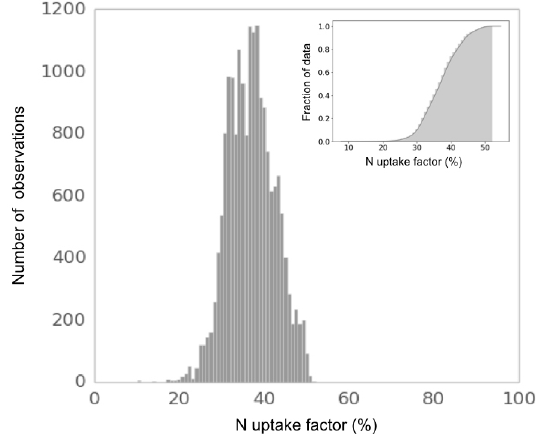
Figure 8. The distribution and cumulative distribution (small graph) of simulated